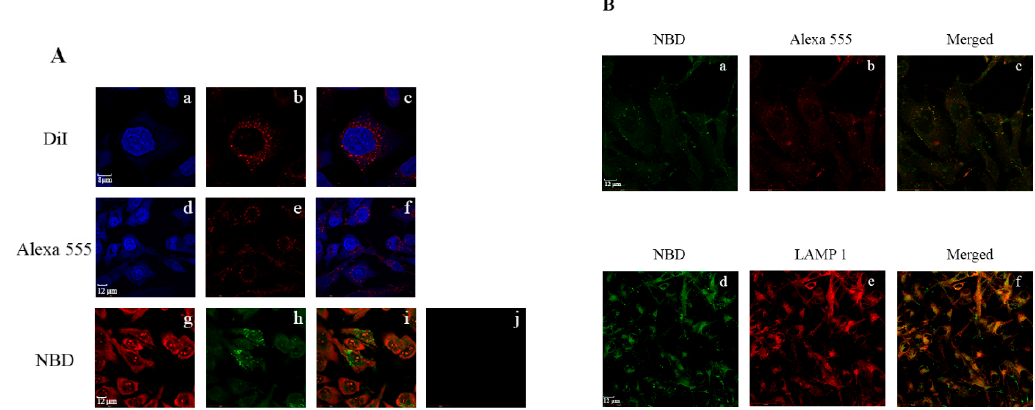
Figure 7. Lysosomal targeting of rHDL/res/NBD by apoE3 in glioblastoma cells. ( A ) Uptake of individual components of rHDL/res was monitored by direct or indirect fluorescence: lipid ( a – c ), apoE3 ( d – f ) and resveratrol ( g – i ). Following exposure to rHDL/res/DiI at 37 °C for 3 h ( a – c ), the cells were visualized under a confocal laser scanning microscope: ( a ) DAPI; ( b ) DiI; ( c ) merge of ( a ) and ( b ). Following exposure to rHDL/res under the same conditions ( d – f ), the cells were visualized by: ( d ) DAPI; ( e ) apoE3 monoclonal antibody, 1D7, and Alexa555-conjugated secondary antibody; ( f ) merge of ( d ) and ( e ). Following exposure to rHDL/res/NBD (5 μ g) as described above ( g – i ), the cells were visualized by: ( g ) propidium iodide; ( h ) resveratrol conjugated to 4-chloro-7-nitrobenz-2-oxa-1,3-diazole (res/NBD); ( i ) merge of ( g ) and ( h ). Panel (j) shows that uptake of res/NBD is minimal in the absence of rHDL. ( B) Co-localization of res/NBD with apoE3, or with LAMP1 in late endosomal/lysosomal vesicles following cellular uptake of rHDL/res/NBD. Following exposure to rHDL/res/NBD, the cells were visualized by fluorescence associated with: ( a ) NBD to detect res, ( b ) Alexa555-conjugated secondary antibody to detect apoE3; ( c ) merge of ( a ) and ( b ); ( d ) NBD to detect res; ( e ) Alexa 594-conjugated secondary antibody to detect LAMP1; ( f ) merge of ( d ) and ( e ). Reproduced with permission from [63]. Copyright Public Library of Science, 2015.